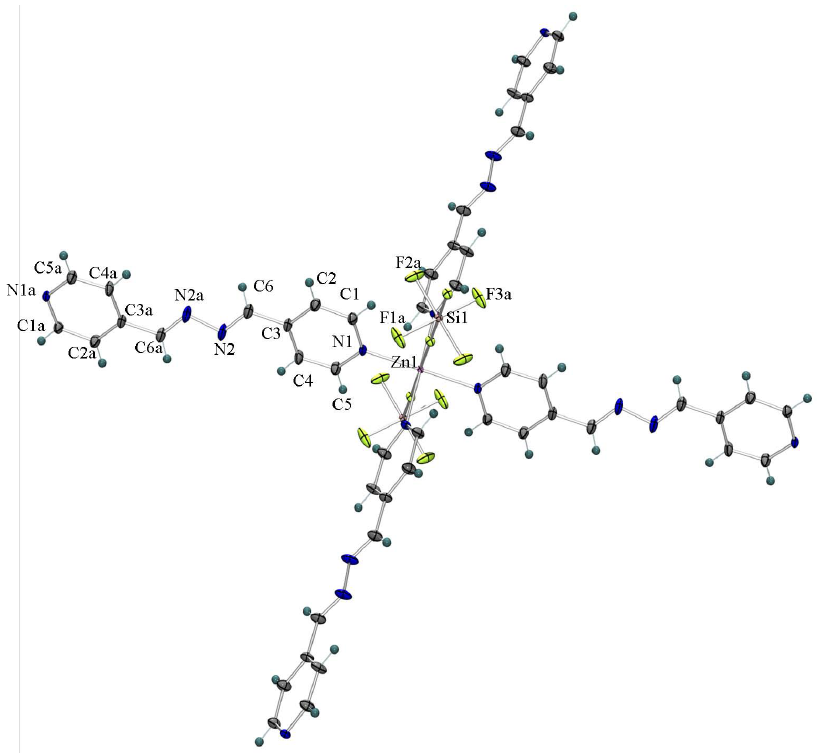
Figure 1. Ortep diagram showing coordination sphere around Zn(II) metal ion in thermal ellipsoids (50% probability). Symmetry codes for related atoms in the asymmetric unit: (i) x, y, z; (ii) − x, y, − z; (iii) 1/2 + x, 1/2 + y, − z; (iv) 1/2 − x, 1/2 + y, − z; (v) − x, − y, − z; (vi) x, − y, z; (vii) 1/2 − x, 1/2 − y, − z; (viii) 1/2 + x, 1/2 − y, z.